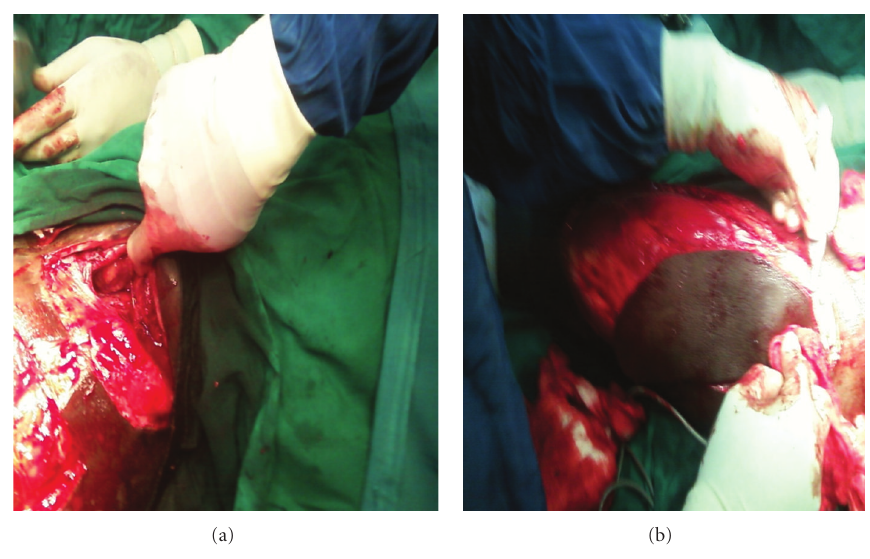
Figure 2: Defect and